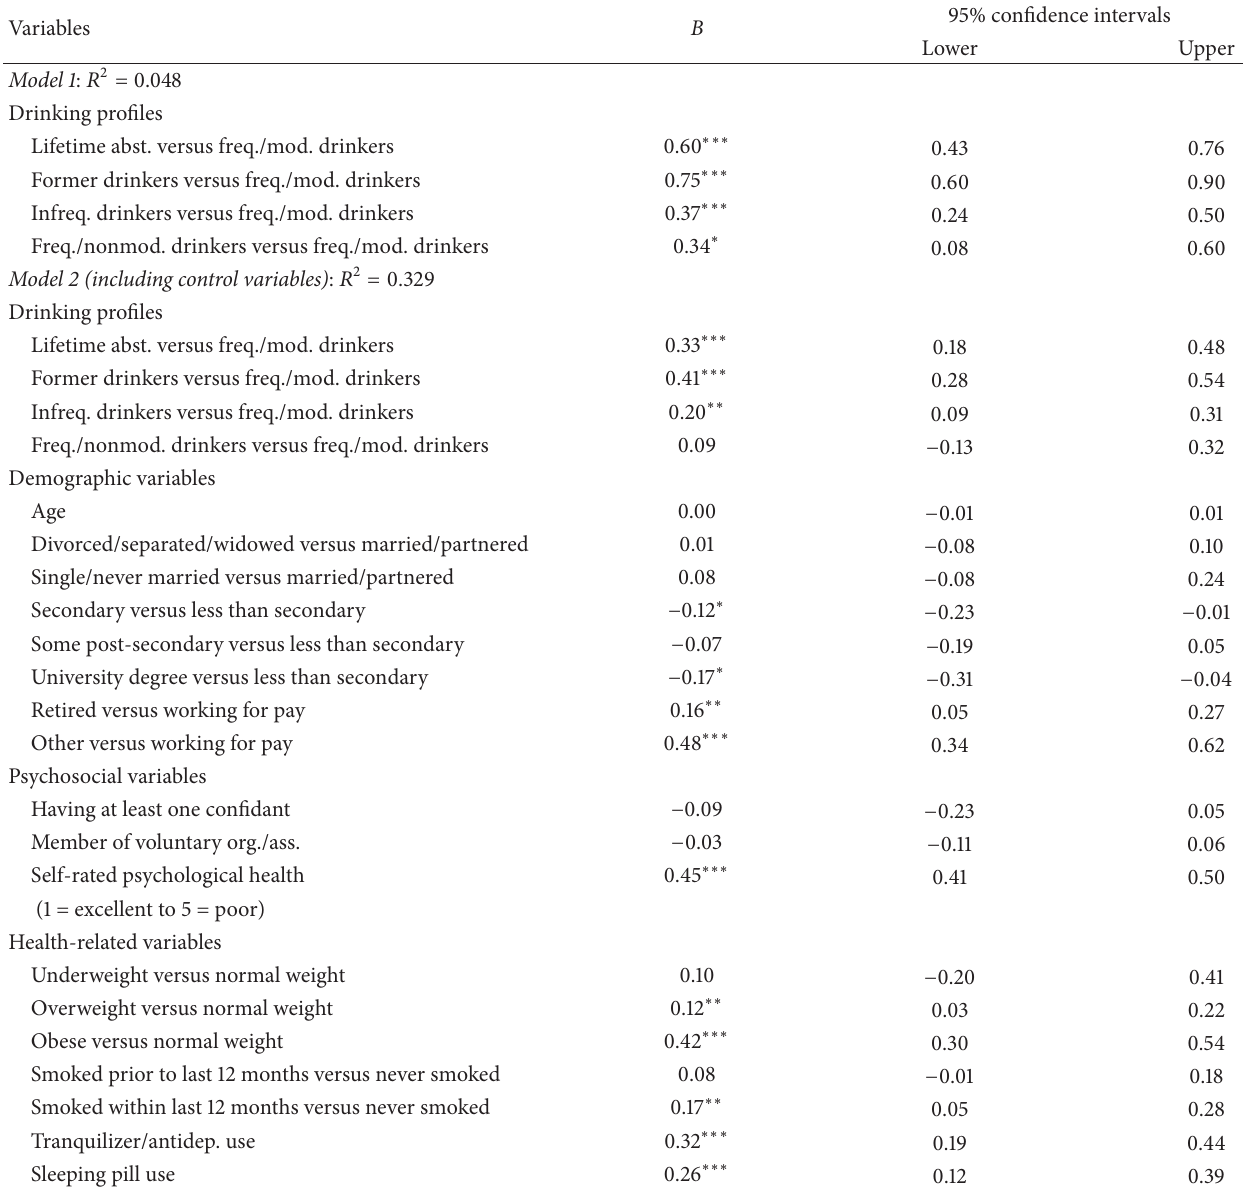
Table 4: Regression analysis of self-rated health among women, 55–74 years of age ( 𝑛 =